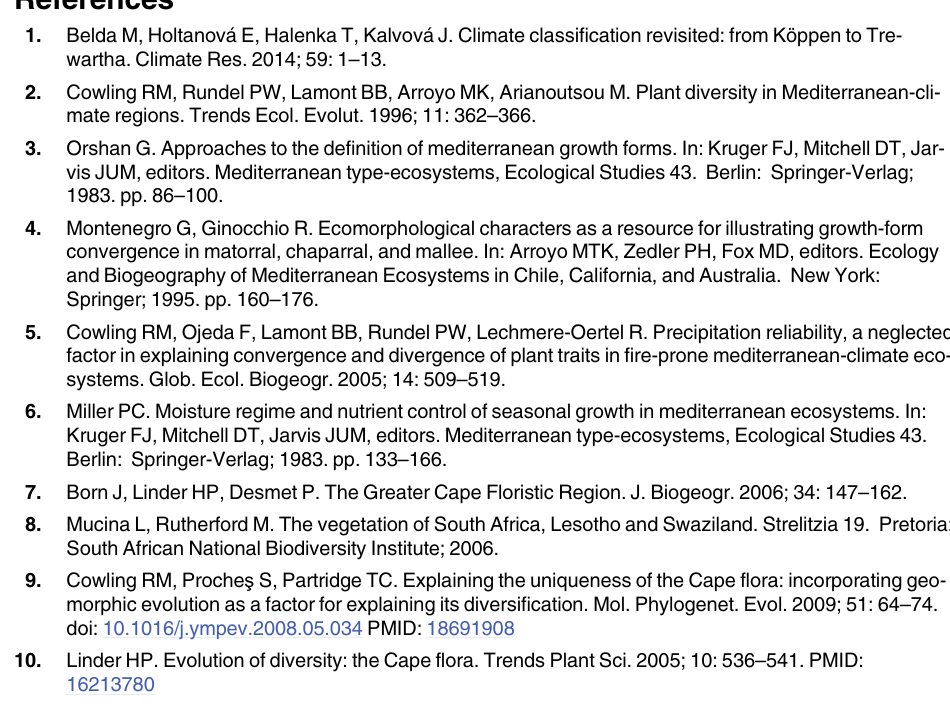
S2 Fig. Map of the variation in annual averages of monthly water availability (precipitation — potential evapotranspiration, P-PET, mm) for South Africa. National and provincial bor- ders are indicated. (TIF) S3 Fig. Variation of total exchangeable bases (TEB) with water availability (P-PET) for all the individual sites sampled. The solid, dashed and dotted lines represent the 95%, 50% and 5% quadratic quantiles, respectively, estimated using the ‘ quantreg ’ package [60] in R [57]. (TIF) S1 Table. The average ± SE for each South African vegetation type of the months during which temperature (T), precipitation (P), normalized difference vegetation index (NDVI) and precipitation — potential evapotranspiration (P – PET) were maximum. Vegetation types are as defined by Mucina and Rutherford [8], but with the Fynbos separated into strandveld, renosterveld and fynbos. Different letters indicate significant (P < 0.05) differences between vegetation types as determined by one-way ANOVA followed by post-hoc Tukey tests. The val- ues are arranged from predominantly summer to predominantly winter rainfall (Table